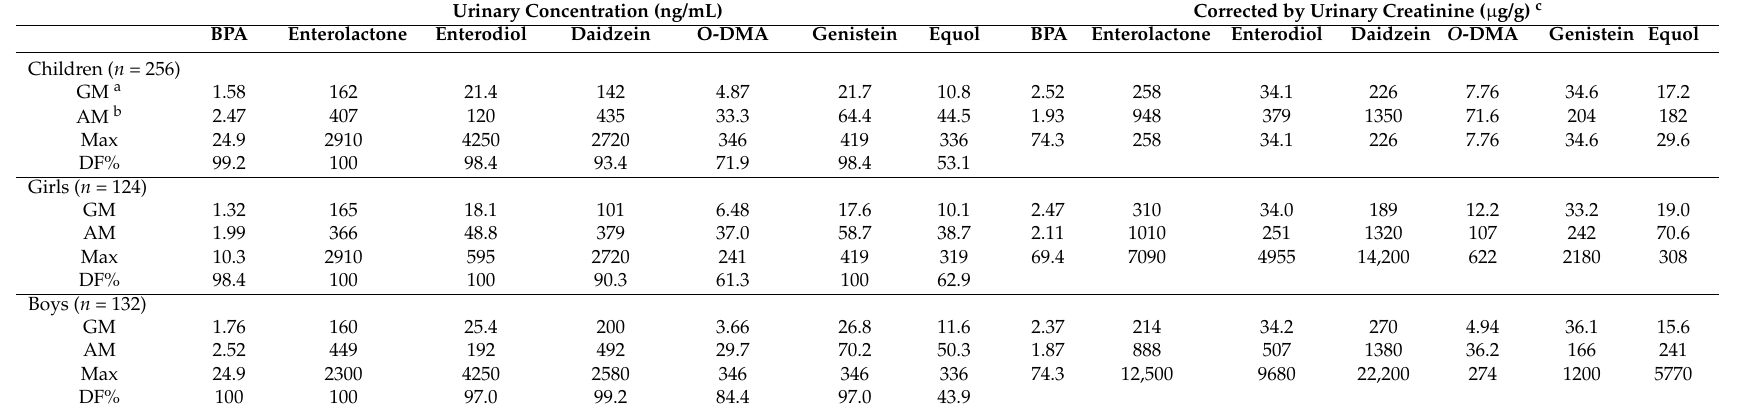
Table 1. Occurrence of BPA and phytoestrogens in urine of children from Tianjin,